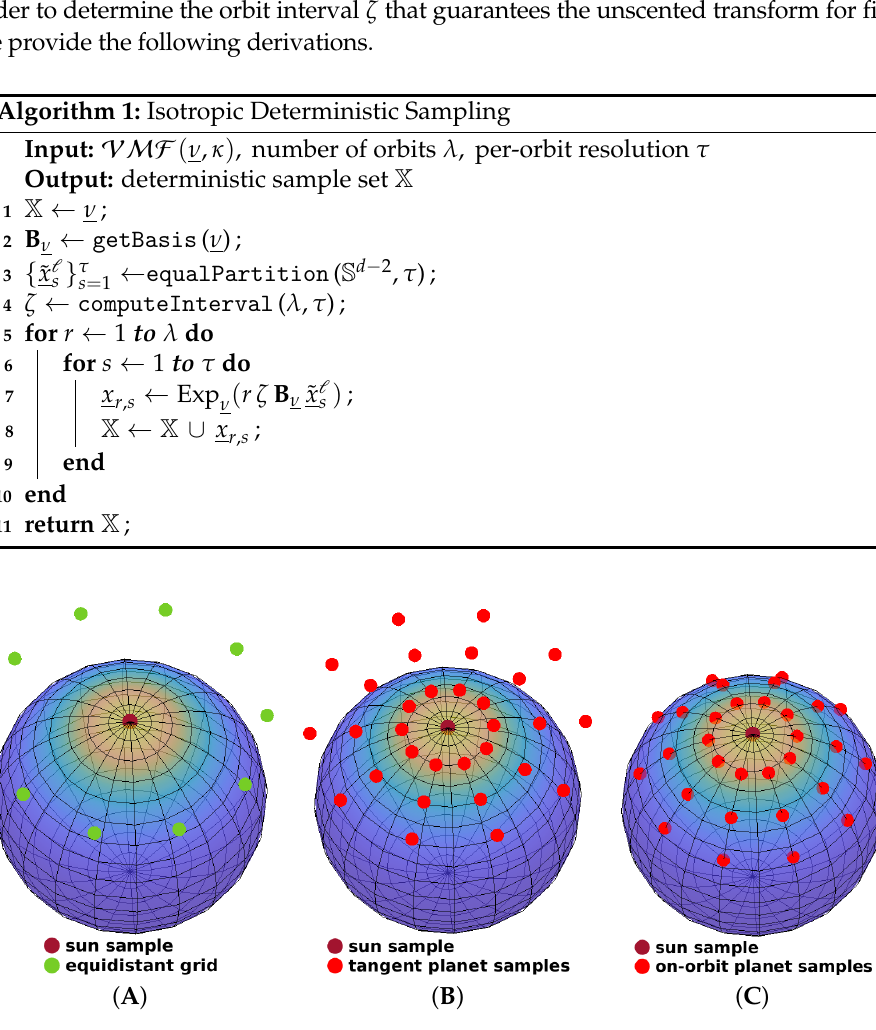
Figure 1. Illustration of isotropic deterministic sampling with ( λ , τ ) = ( 3,10 ) for a von Mises–Fisher distribution ( κ = 4) on S 2 . ( A ) Equal partitioning in T ν S 2 with regard to its local basis. ( B ) Scaling with the UT-preserving interval in T ν S 2 . ( C ) Exponential map from T ν S 2 to S 2 for placing planet samples on hyperspherical